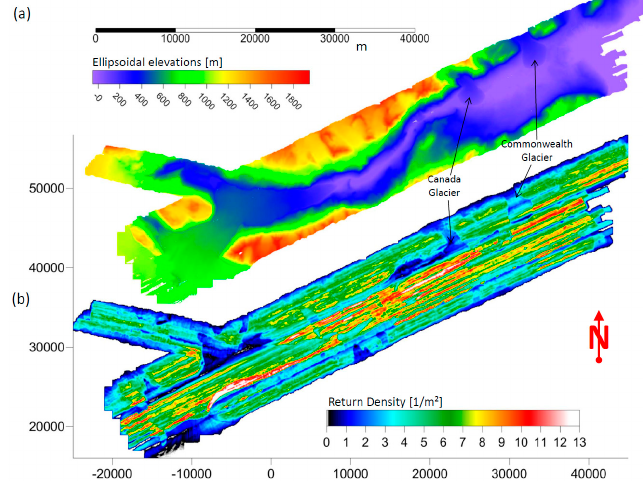
Figure 12. Image maps for the Taylor and Pearse valleys in Antarctica. ( a ) Image map showing the topographic relief of the valleys based on the lidar DEM; ( b ) Image map showing the laser return density obtained from the valleys.